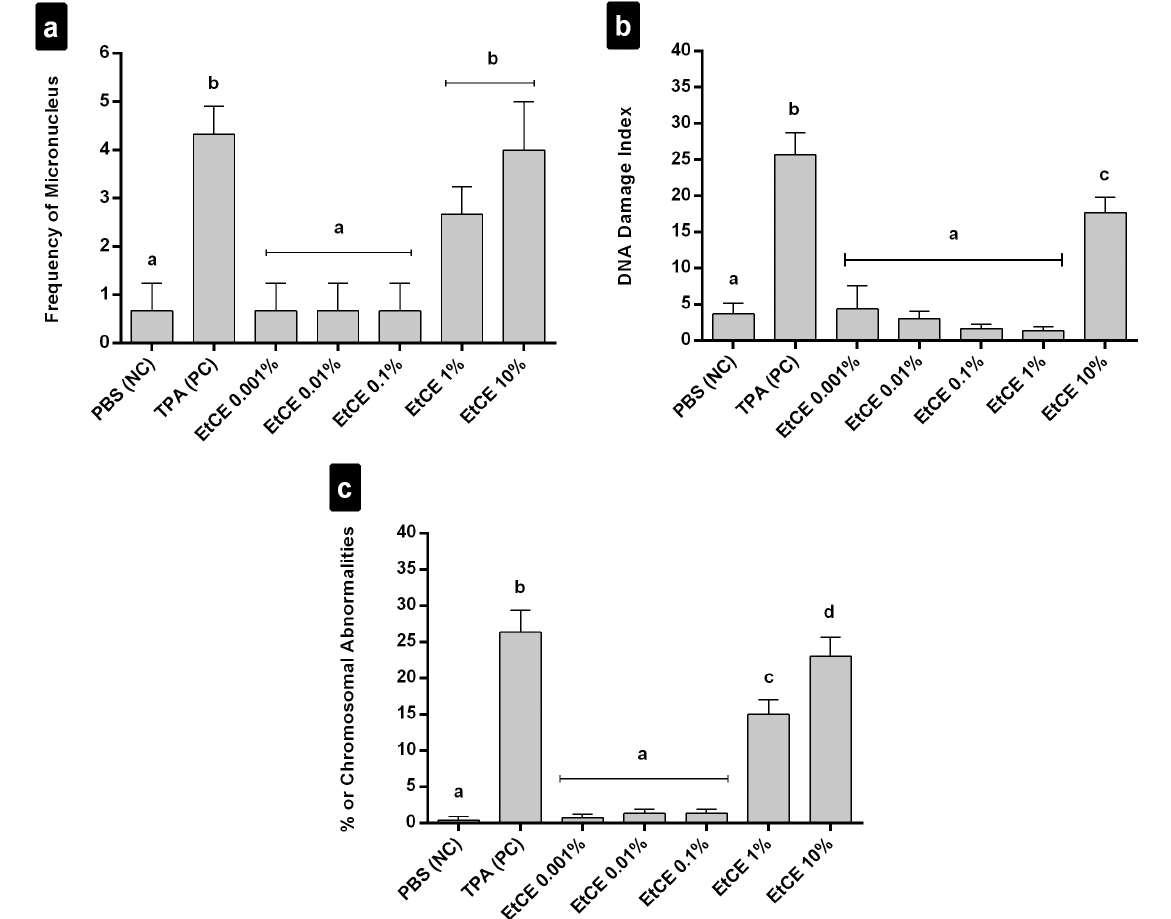
Figure 3 - Markers of genotoxic effects. Markers were the frequency of micronuclei (a) , DNA damage by comet assay (b) , and chromosomal abnormalities (c) . PBS: Phosphate-buffered saline, TPA: 12-O-tetradecanoylphorbol-13-acetate, EtCE: Euphorbia tirucalli crude extract. Data are presented as mean ± SD (n = 3). The letters indicate statistically signi fi cant